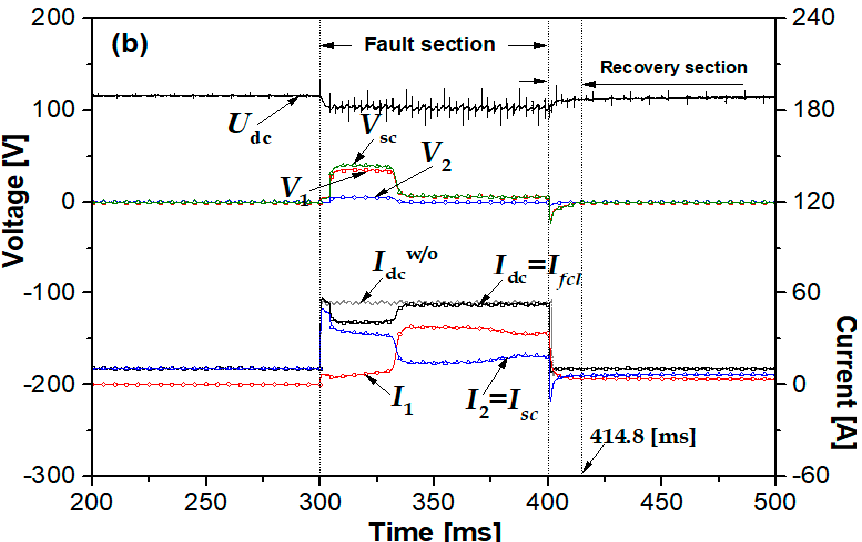
Figure 5. Current and voltage relationship curves of the DC system models, including the flux- coupled type SFCL, in accordance the wiring direction: ( a ) for additive wiring; ( b ) for subtractive wiring.